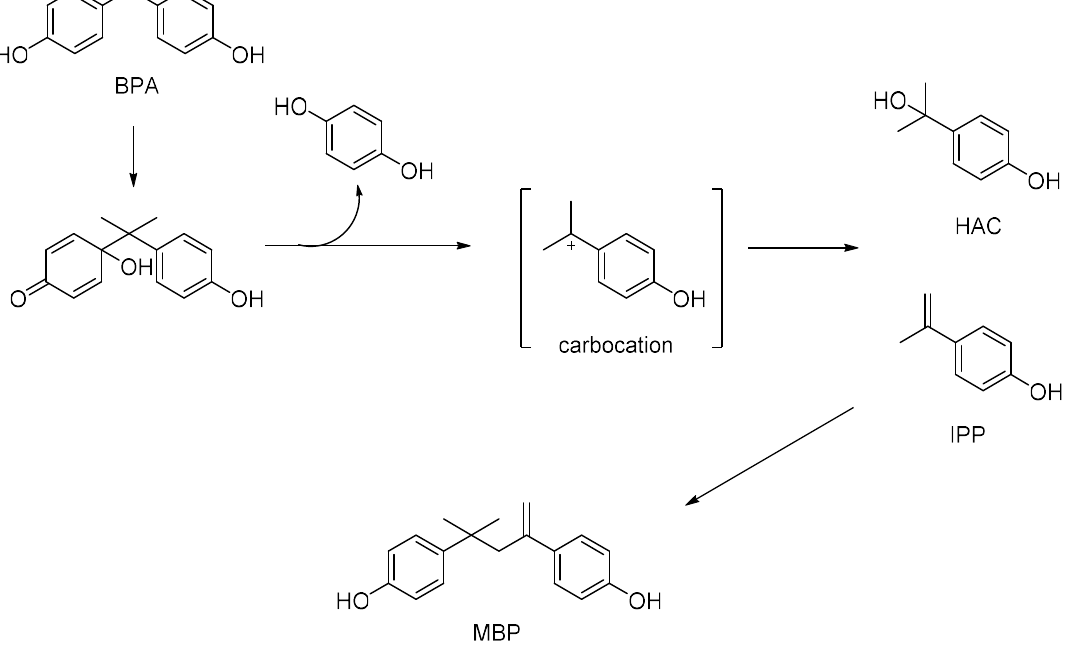
Figure 2. Suggested mechanism of formation the three estrogenic metabolites of